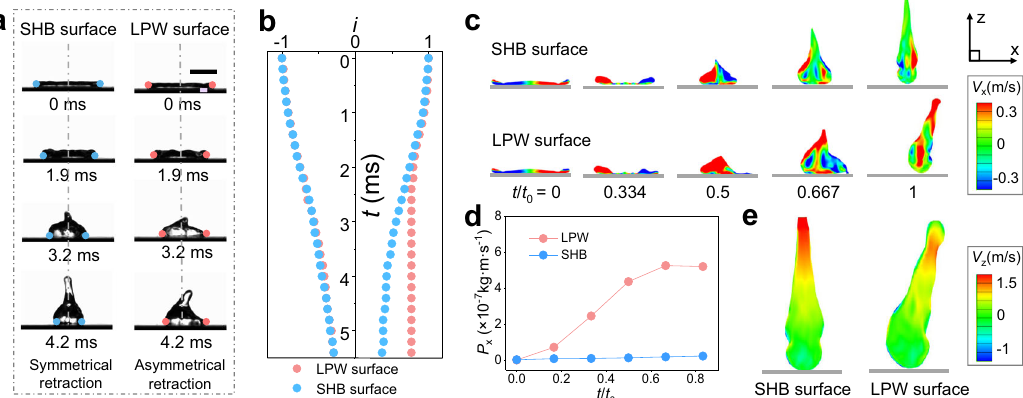
Fig. 2 Dynamics of the asymmetrical and symmetrical droplets retraction. a Snapshots of the symmetrical droplet retraction after impacting on the SHB surface, and the asymmetrical droplet retraction after impacting on the LPW surface. We = 32.8. Scale bar: 2 mm. b Plot of the TCL position i (de fi ned as the ratio of the position of the droplet ’ s ends and the droplet radii) of the symmetrical and asymmetrical retracting droplets. c Simulated results to show the evolution of the lateral ( x -direction) velocity distribution in the cross-section of the droplets. d The momentum of the droplet along the x -direction ( P x ) during the retraction process. e The vertical velocity gradient ( z -direction) inside the droplets at t / t 0 =